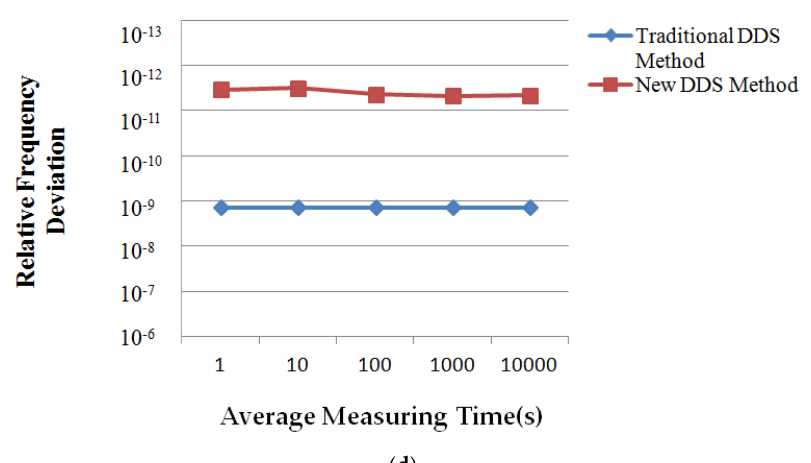
Figure 10. Measurement of accuracy. ( a ) 1.024 MHz signal accuracy; ( b ) 2.048 MHz signal accuracy; ( c ) 5 MHz signal accuracy; ( d ) 10 MHz signal accuracy.